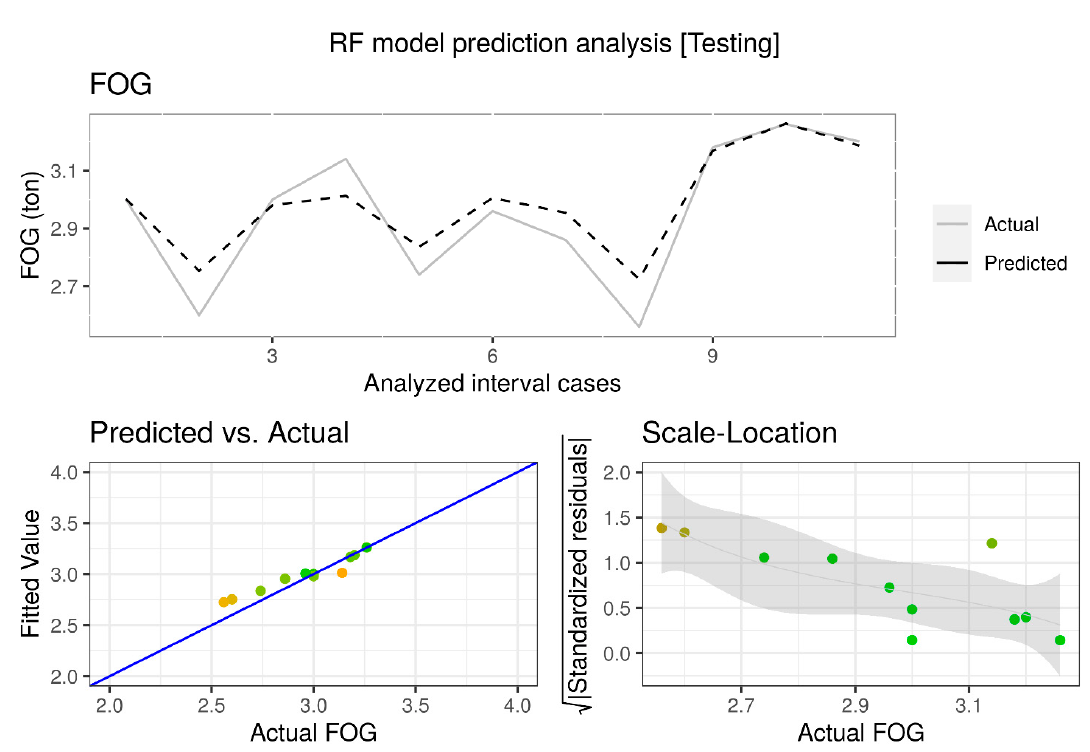
Figure 9. RF model prediction analysis (testing).